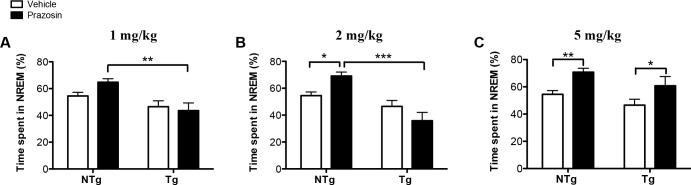
Prazosin differentially affects NREM sleep in 3.5-month-old TgCRND8 and NTg mice.Time spent in NREM sleep during the 2-hour period following administration of the α1-adrenergic antagonist, prazosin, at 1 (A), 2 (B) and 5 (C) mg/kg versus vehicle in 3.5-month-old NTg and TgCRND8 mice. Prazosin or vehicle was administered at 10:00 AM via an intraperitoneal injection. (A) Treatment with Prazosin at 1 mg/kg does not significantly affect the percent time spent in NREM sleep when compared to vehicle in both NTg and TgCRND8. (B) At 2 mg/kg, treatment with Prazosin significantly increases the time spent in NREM sleep in comparison to vehicle in NTg mice only. The observed increase in NREM sleep in NTg following treatment with 2 mg/kg prazosin differed significantly from time spent in NREM sleep following treatment with 2 mg/kg in TgCRND8. (C) At 5 mg/kg, prazosin significantly increases time spent in NREM sleep in both NTg and TgCRND8 mice. Error bars represent SEM. NTg vehicle n = 11, NTg 1, 2 and 5 mg/kg n = 8, Tg vehicle n = 11, Tg 1 and 2 mg/kg n = 9, Tg 5 mg/kg n = 6. Fig 5A, 5B and 5C were analyzed by individual two-way ANOVAs comparing each prazosin dose to vehicle, followed by Tukey’s post-hoc or simple effects analysis where appropriate, * P<0.05, ** P<0.01, *** P<0.001.